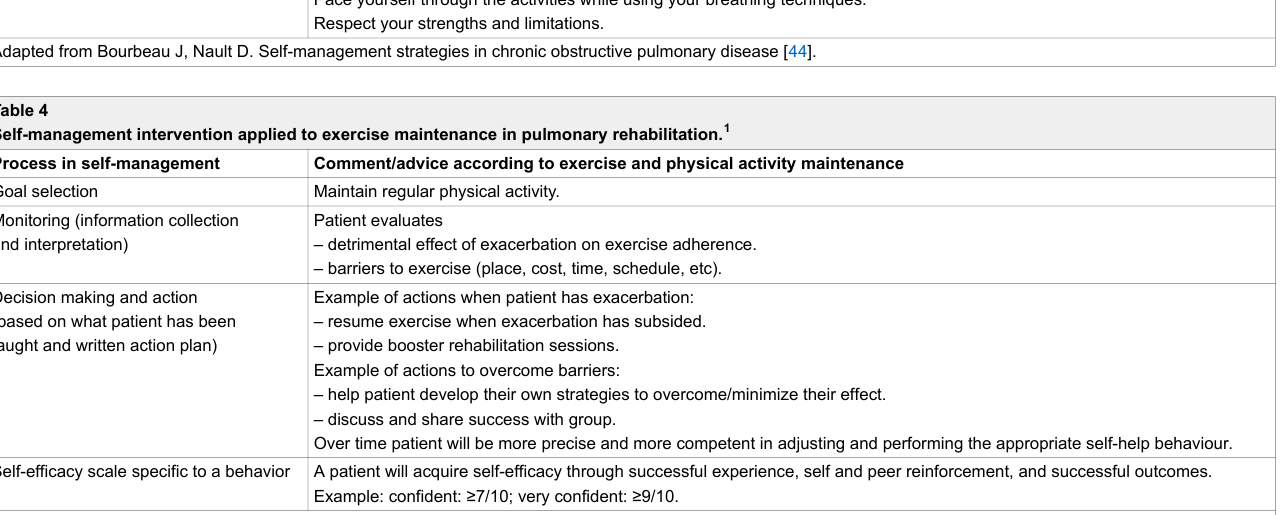
Table 4 Self-management intervention applied to exercise maintenance in pulmonary rehabilitation.